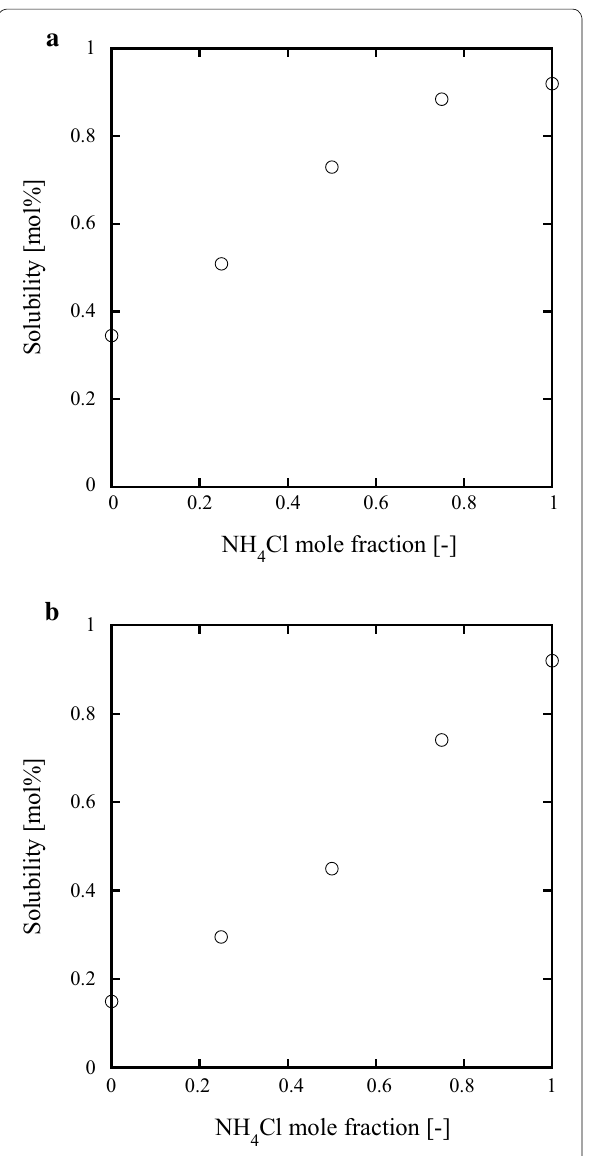
Fig. 1 Mineralizer-composition dependence of GaN solubility in supercritical ammonia (450 °C, 100 MPa, and 3.1 mol% mixed mineralizer): a NH 4 Cl NH 4 Br; b NH 4 Cl NH 4 I + +